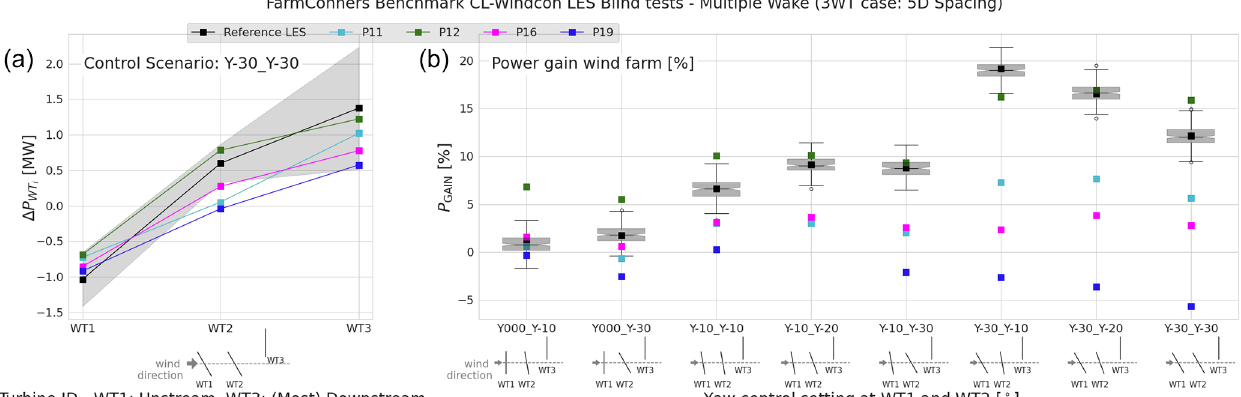
Figure 18. CL-Windcon LES blind tests, multiple wake under wake steering for the three-turbine configuration (3WT) with 5D spacing. (a) Power difference (mean) in absolute values (MW) per turbine, when WT1 and WT2 are both − 30 ◦ misaligned (Y-30_Y-30). (b) Power gain (mean) per control setting in the three-turbine wind farm. Boxplots represent the distribution of the reference CL-Windcon LES time series per control setting listed in Table 7. Representative layouts with corresponding yaw control settings are illustrated along the x axes.